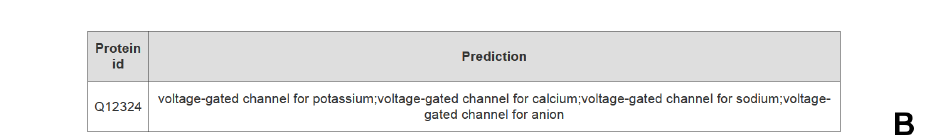
Figure 4. Web interface of the PSIONplus m webserver at https://yanglab.nankai.edu.cn/PSIONplusm/. Panel ( A ) shows the main page of the webserver while panel ( B ) shows an example output produced by the webserver.